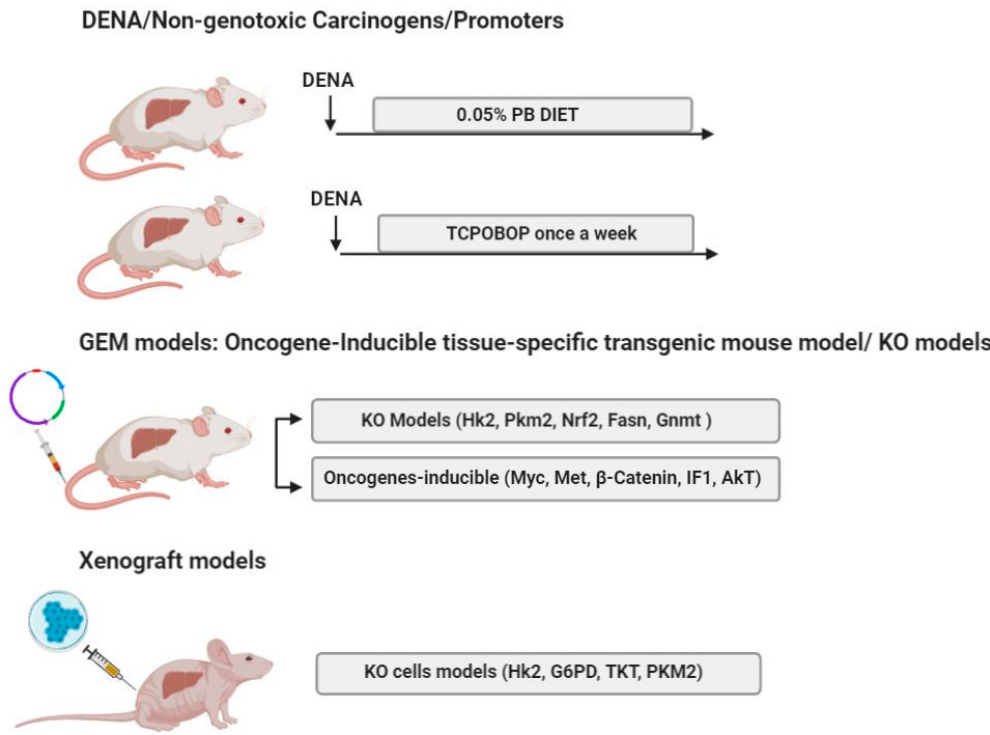
Figure 2. Examples of mouse models used for the study of metabolic reprogramming in HCC. DENA: